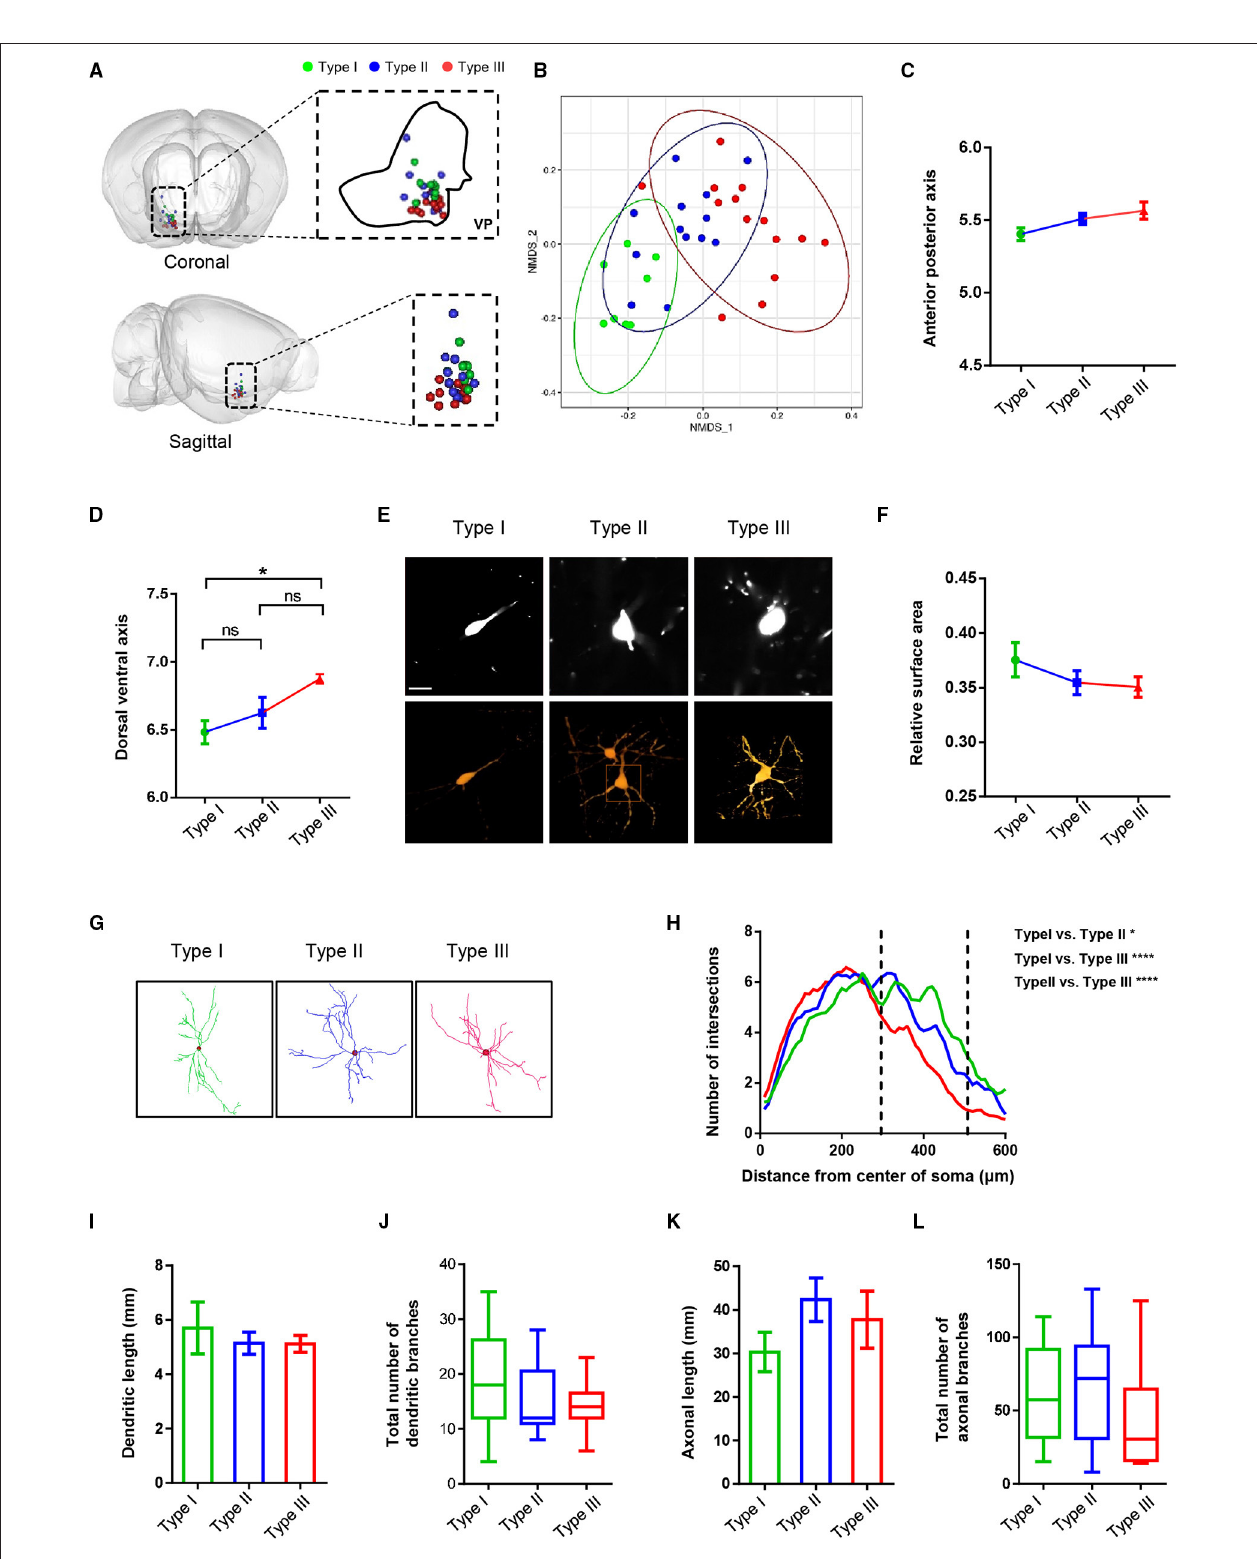
FIGURE 5 | The morphological characteristics of VP neurons at the level of somata and dendrites. (A) Cell body position distribution of reconstructed neurons in the VP (the green blot is type I, the blue blot is type II, and the red blot is type III; top, coronal view; bottom, sagittal view). (B) Non-metric multidimensional scaling (NMDS) plot of cell body clusters. (C,D) Statistical comparisons of the cell body location along the anterior-posterior axis (C) and the dorsal-ventral axis (D) . The error bars